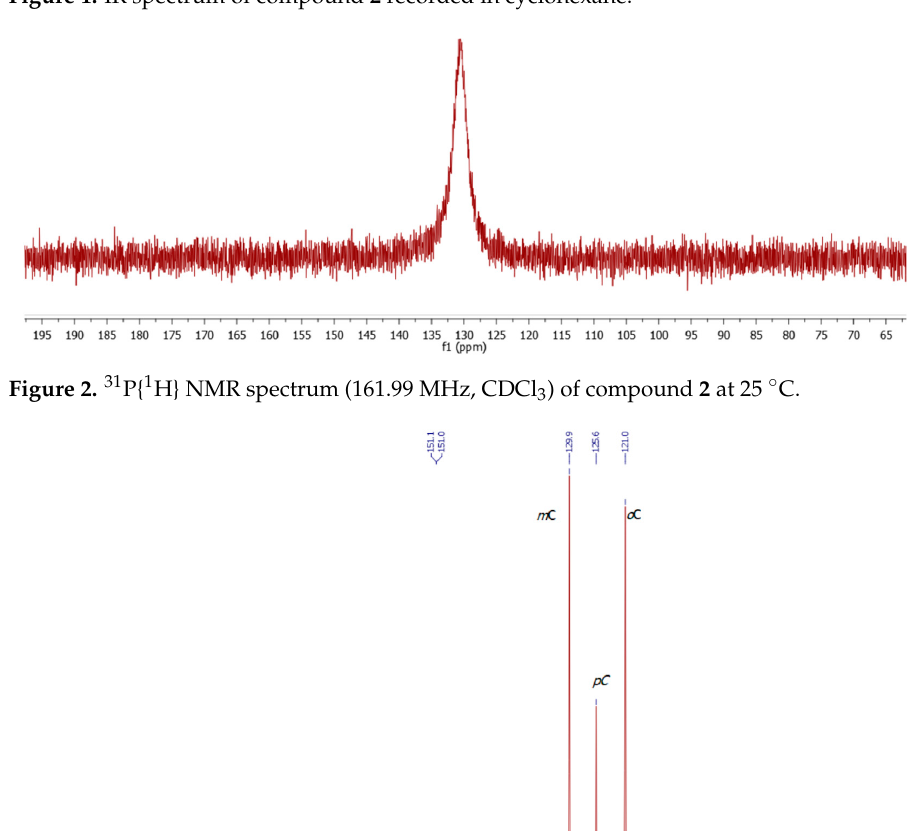
Figure 2. 31 P{ 1 H} NMR spectrum (161.99 MHz, CDCl 3 ) of compound 2 at 25 °C .